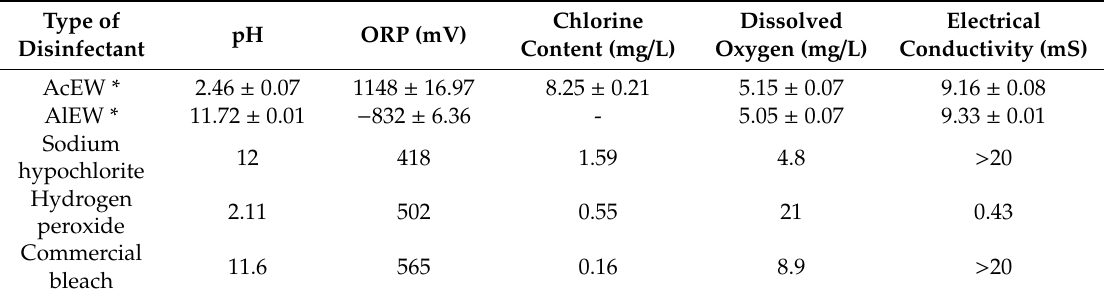
Table 14. Comparison of characteristics of other types of disinfectants with EW.